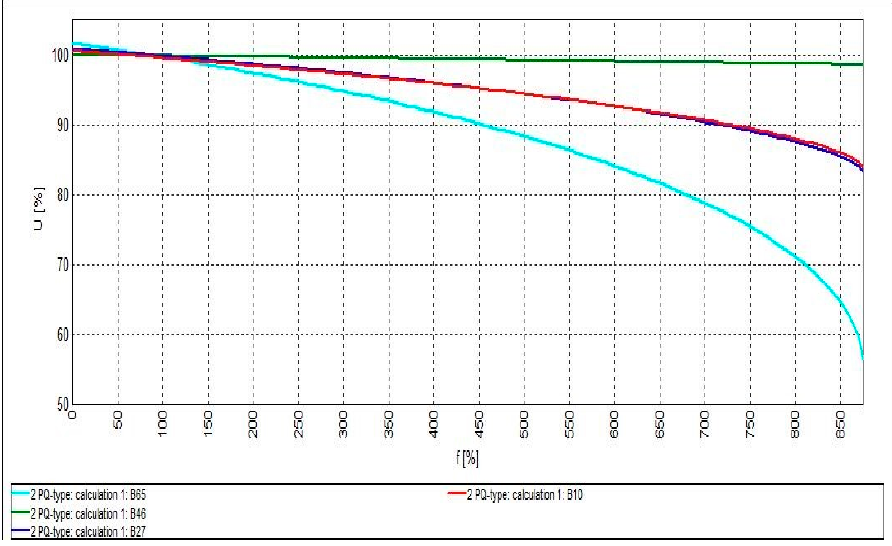
Figure 11. PV curves of the IEEE 69 ‐ node RDS system with 2 PQ ‐ type DG installations.